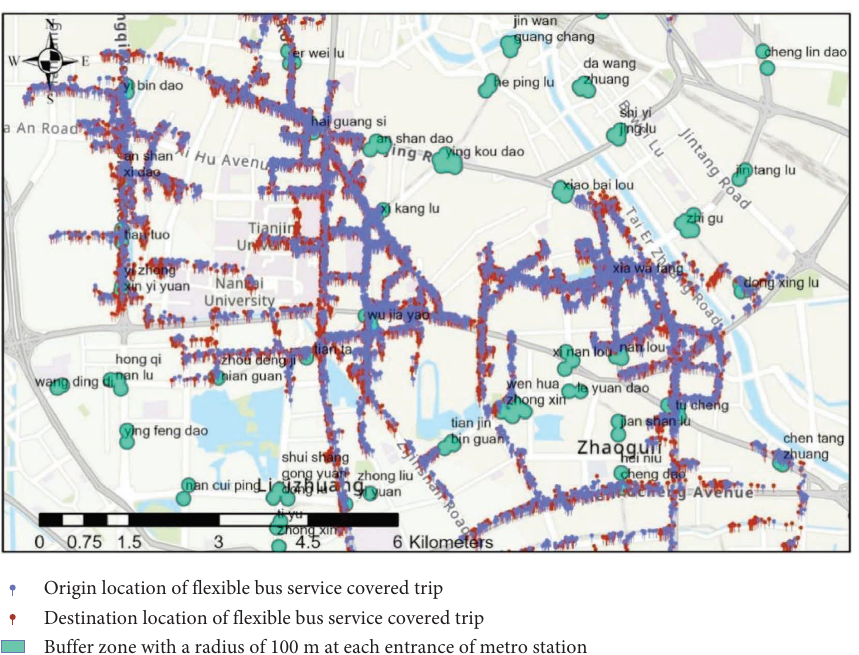
Figure 11: Visualize how many trips covered by fexible bus can fall into the service scope of shuttle bus. Table 8: Verifcation results of FFBS trips covered by fexible bus that can fall into the service scope of shuttle bus during 8:00 to 8:30 in three verifcation